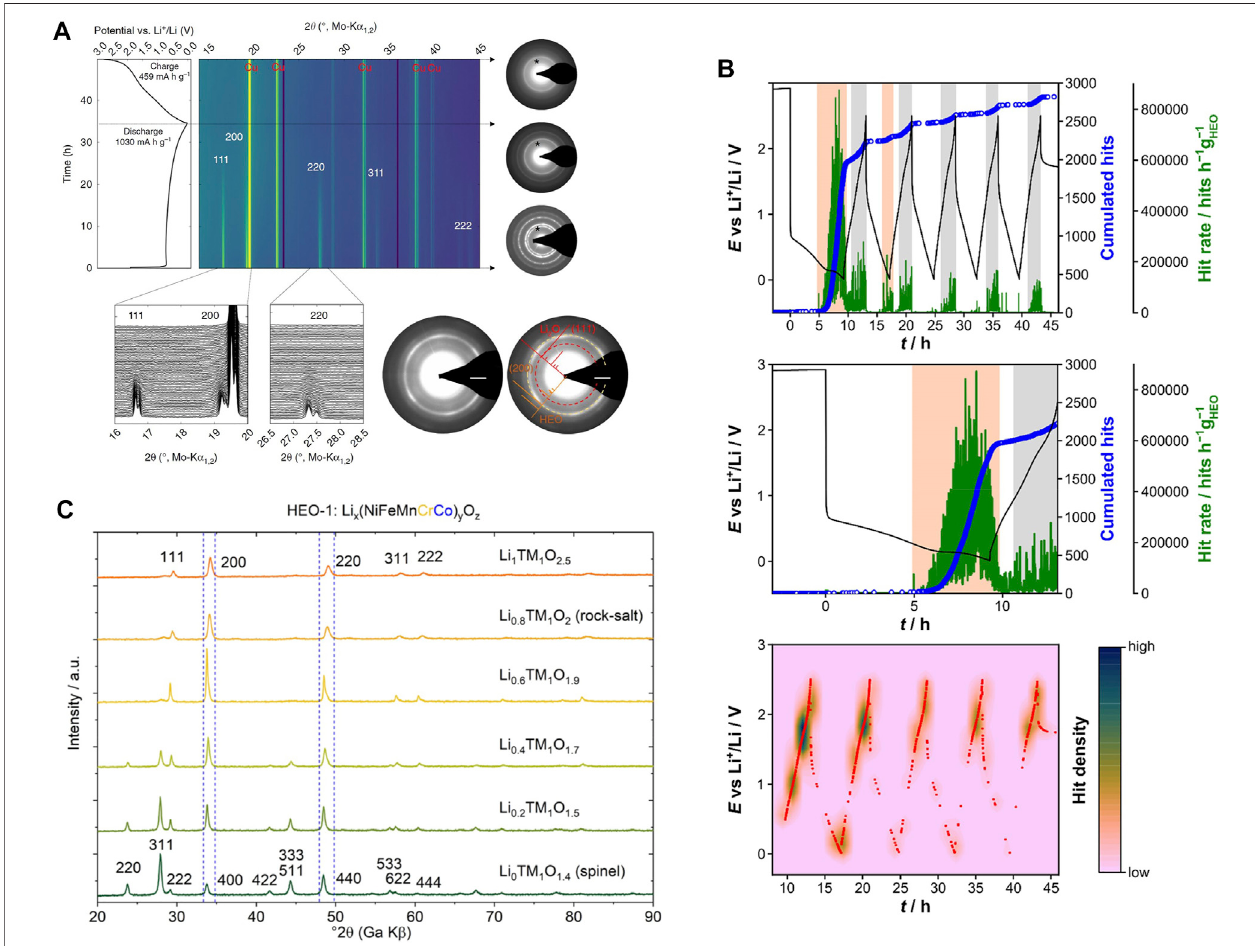
FIGURE 5 | Proposed mechanism for TM-based HEO anode lithiation (Ghigna et al., 2020). Reproduced under the terms of the CC BY license.